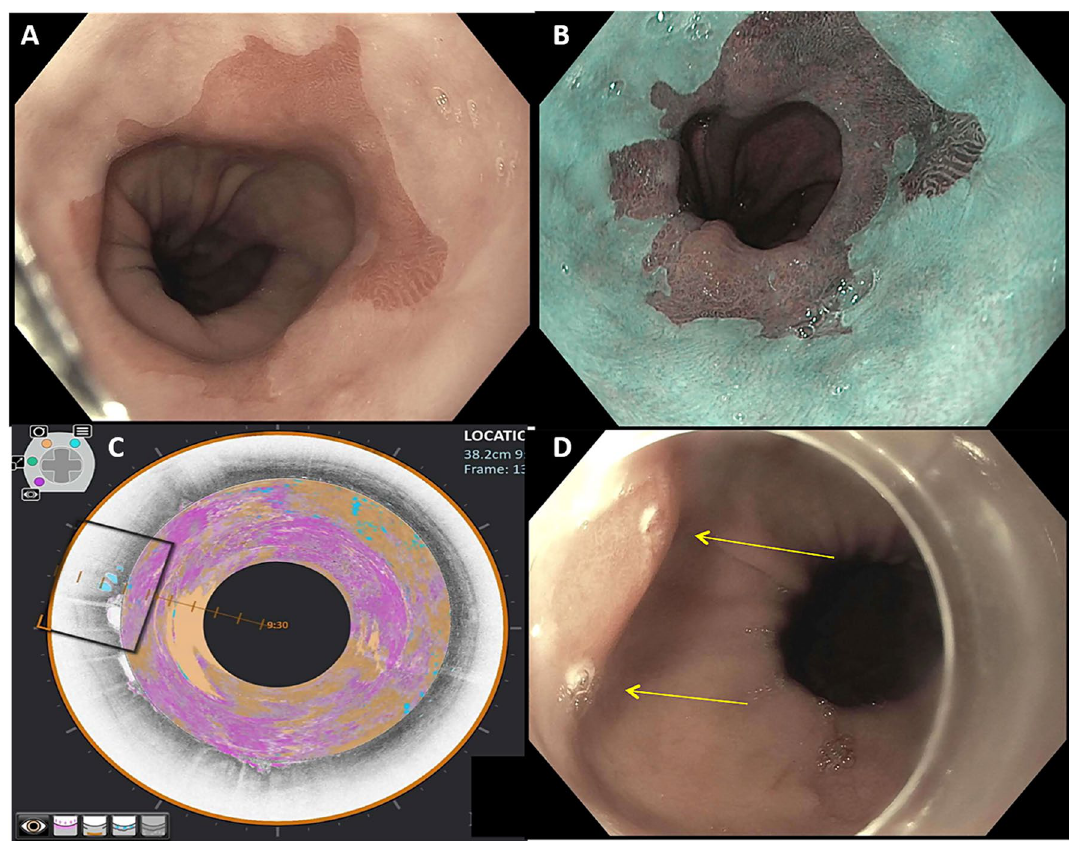
Figure 2. Example of a VLE-IRIS case with endoscopically non-visible dysplasia. Case images from a patient with no endoscopic evidence of dysplasia on ( A ) high-definition white light endoscopy and ( B ) narrow-band imaging. ( C ) VLE with IRIS demonstrates atypical epithelial glands (blue), loss of layering (orange), and increase surface signal intensity (pink). ( D ) Laser marks (yellow arrows) placed during VLE at the site of the abnormality. Biopsies between the laser marks showed high-grade